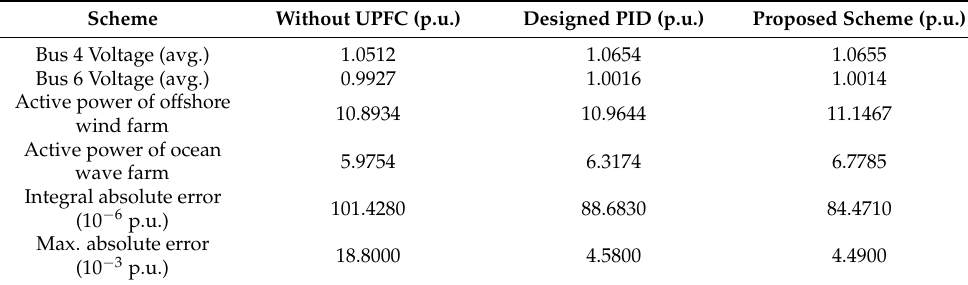
Table 1. Dynamic performance comparison under load disturbance. Scheme Without UPFC (p.u.) Designed PID (p.u.) Proposed Scheme (p.u.)